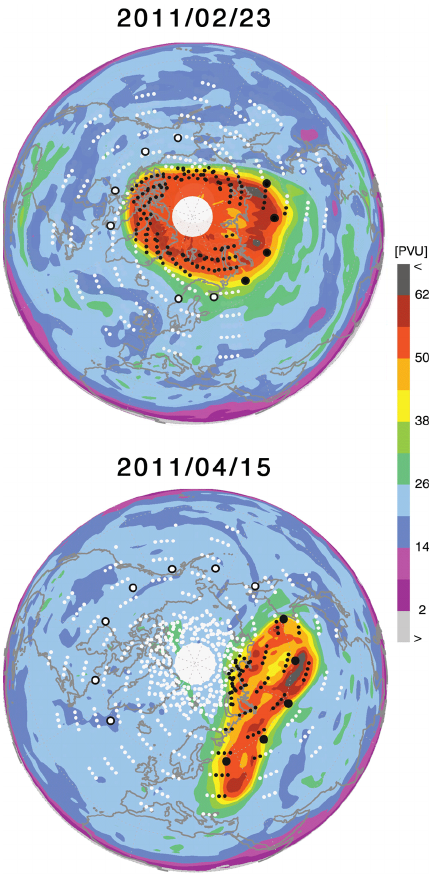
Fig. 7. Polar stereographic projection of the UKMO potential vor- ticity at the 475K isentrope. It also depicts the location of SCIA- MACHY limb measurements (small dots) in comparison to SCIA- MACHY solar-occultation measurements (large dots), relative to the location and shape of the polar vortex on 2 days in winter–spring 2011. The edge of the polar vortex is at approximately 38PVU mod- ified potential vorticity. On 23 February (top), around the onset of the chemical ozone depletion, the vortex had an almost circumpolar shape whereas on 15 April 2011 (bottom) it was highly distorted and shifted towards the Eurasian continent. Measurements lying within the vortex are shaded black, locations outside are shaded white. To better differentiate between limb and solar-occultation measure- ments outside the vortex, the latter are coated